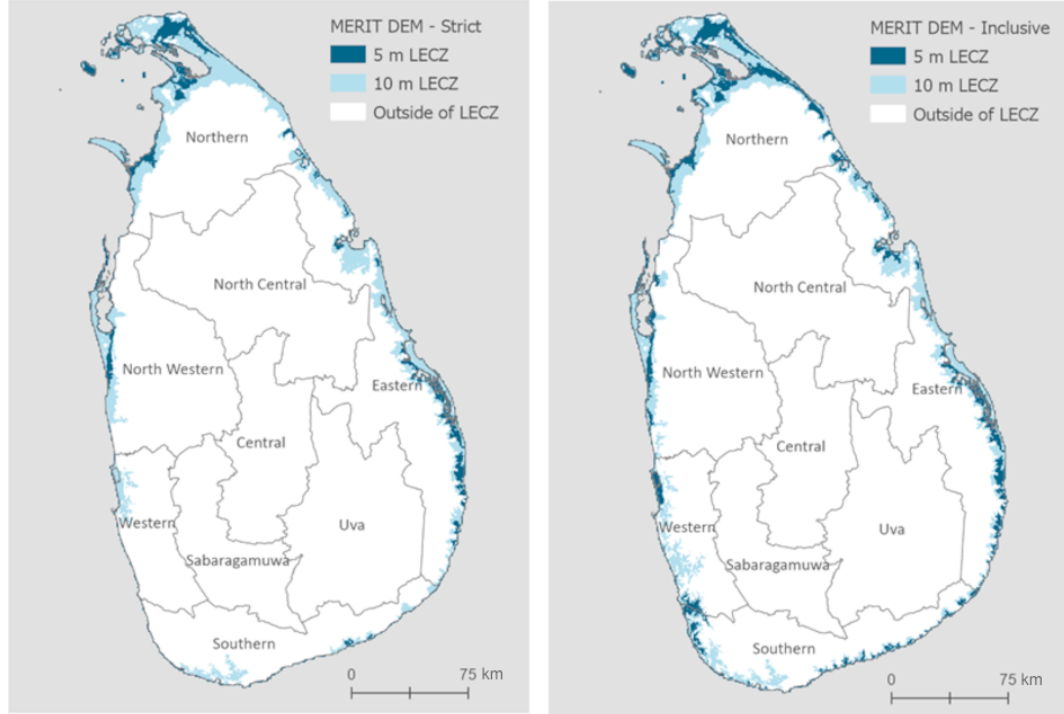
Figure 5. MERIT DEM LECZ constructed strictly and inclusively (with 1km buffer), Sri Lanka.